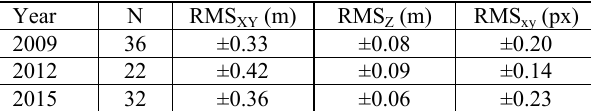
Table 2. Accuracy of longitudinal profile. Photogrammetric data using Agisoft PhotoScan (4 photographs, original image data).